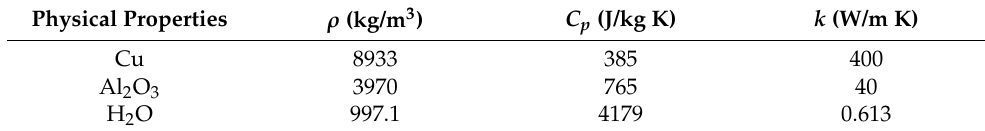
Table 1. Thermal and physical characteristics for the base fluid and nanofluids (see Ahmed et al. [63]). Physical